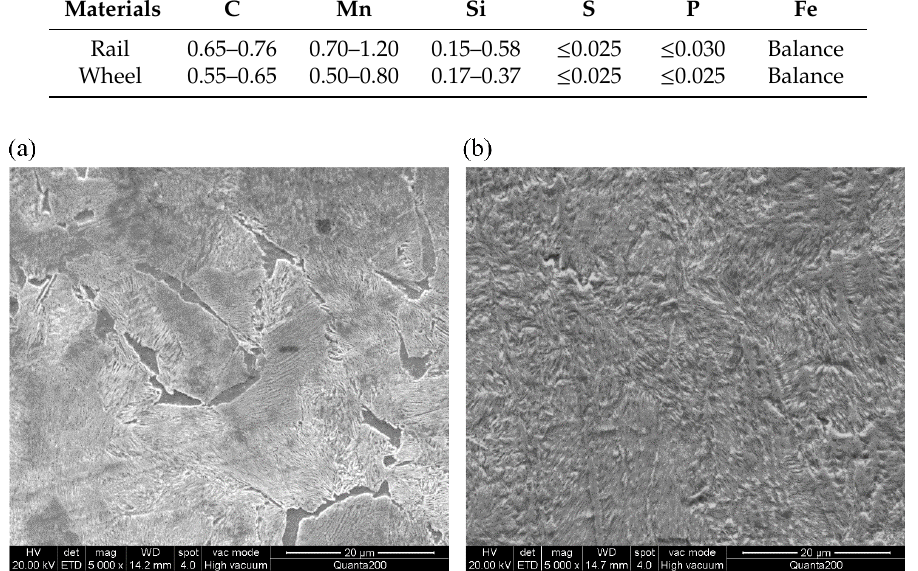
Figure 2. SEM micrographs of wheel / rail specimens: ( a ) wheel steel; ( b ) rail